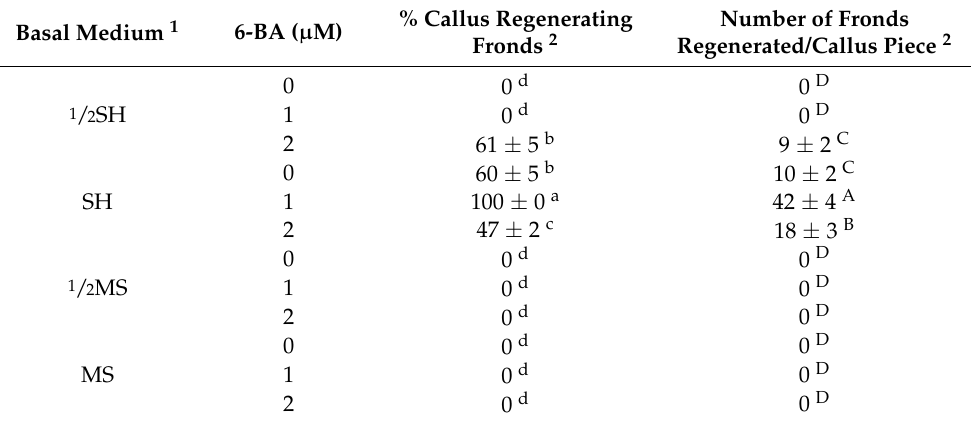
efficiency of frond regeneration from callus after 4 weeks in